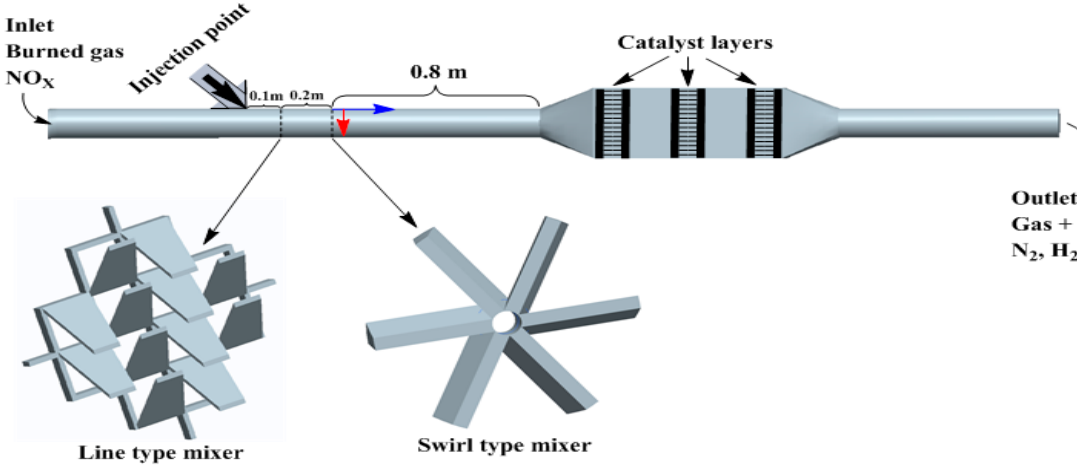
Figure 1. Systematic structure of the selective catalyst reduction (SCR) system.